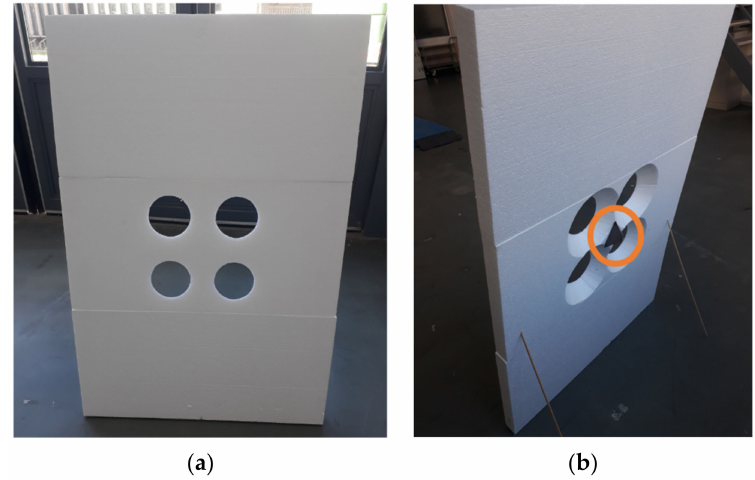
Figure 9. The proposed calibration target design to jointly extrinsic calibrate multiple sensors (radar, camera, LiDAR). It consists of four circulars, tapered holes centrally located within a large rectangular board at the ( a ) front of the board, and a metallic trihedral corner reflector (circled in orange) located between the four circles at the ( b ) rear of the board. Figure source from [146,147] and